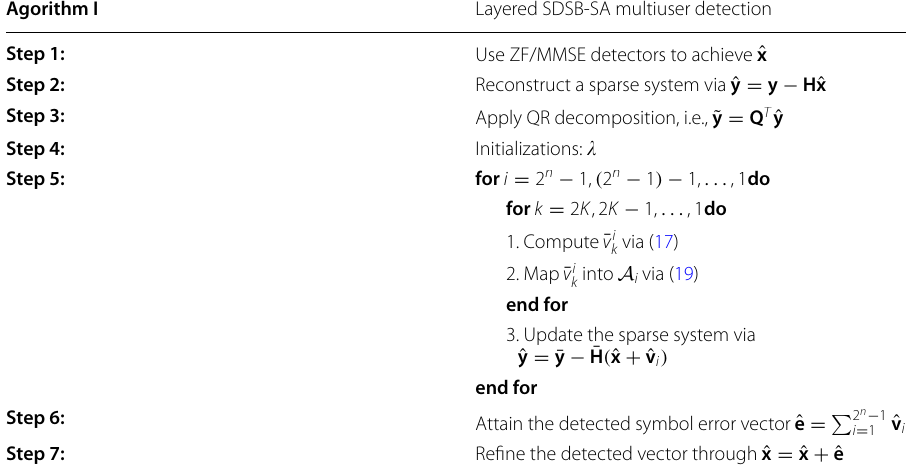
Table 1 Layered single-dimensional search-based sparse-aware multiuser detection Agorithm I Layered SDSB-SA multiuser detection